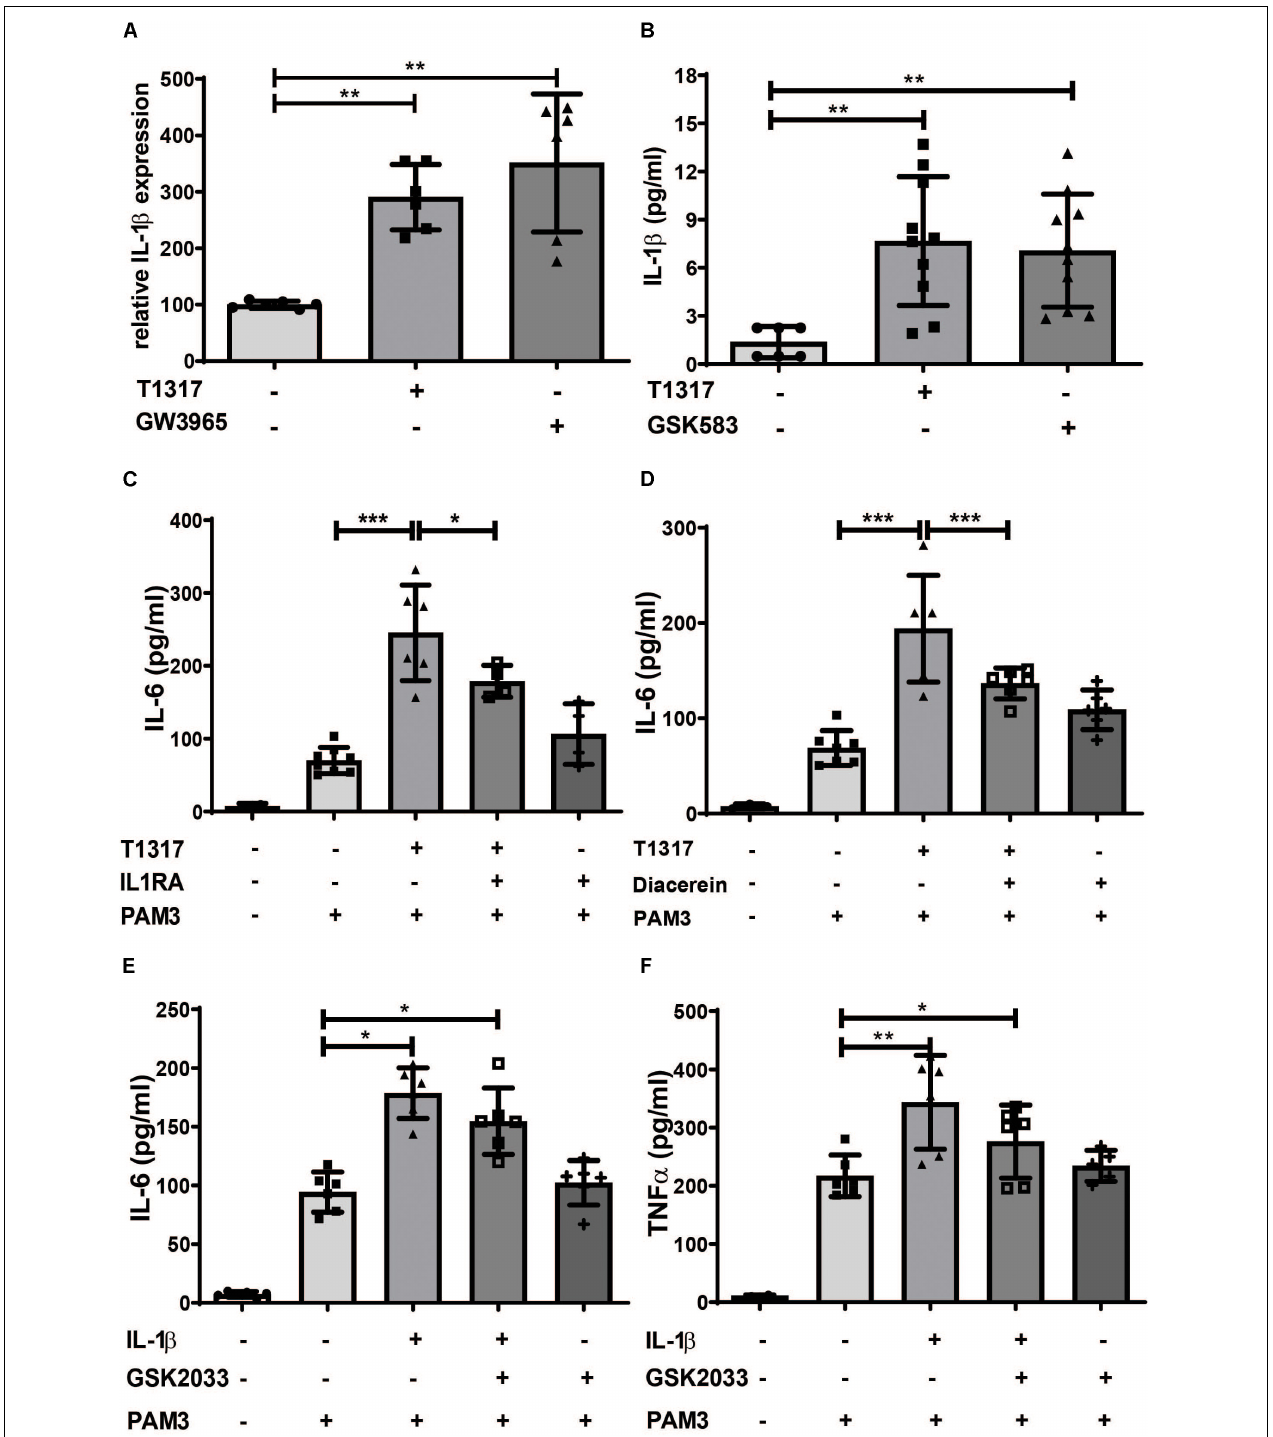
FIGURE 6 | LXR priming is dependent on IL-1 β . Monocytes were treated as indicated with 2 µ M T1317 (LXR agonist), 10 µ M GW3965 (LXR agonist), 5 µ M GSK2033 (LXR antagonist), 1 µ M Diacerein, 10 ng/ml IL-1 β , 200 ng/ml IL1RA (IL-1 receptor antagonist) or vehicle for 24 h. (A) mRNA levels of IL-1 β , were analyzed by real-time qPCR. (B) 24 h after priming medium was changed and after 24 h resting time supernatant was collected and the level of IL-1 β was measured using ELISA. (C–F) cells were kept for 5 days in complete medium and restimulated with 5 µ g/ml Pam3cys for 24 h. IL-6 (C–E) and TNF α (F) were measured in the supernatant. Graphs represent mean values ± SD of six individuals in three different experiments. * P < 0.05, ** P < 0.01 and *** P < 0.001.